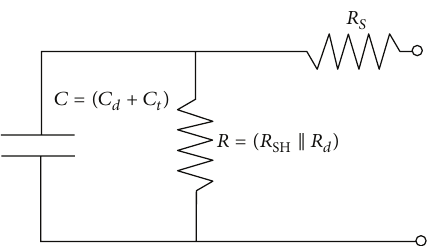
Figure 7: The ac equivalent circuit of LCPV module to explain observed impedance